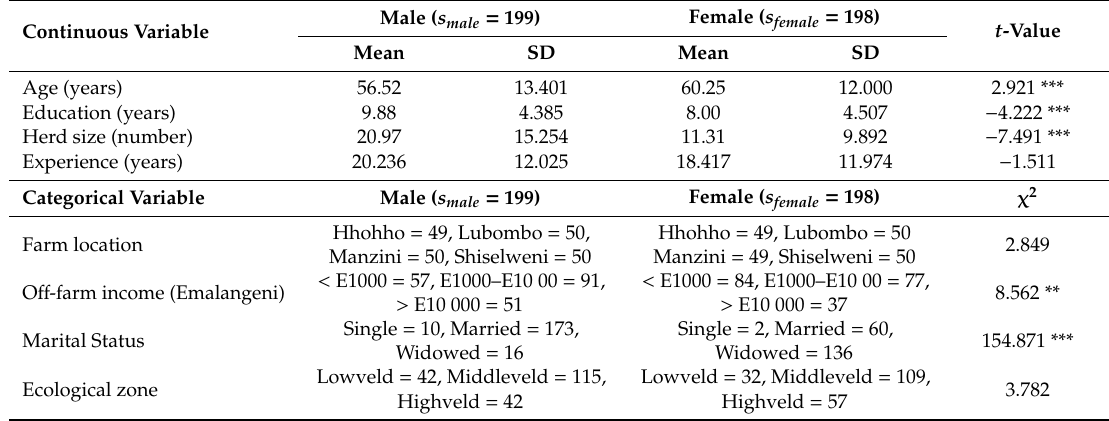
Table 1. Gender-based comparison of farmers’ socio-economic